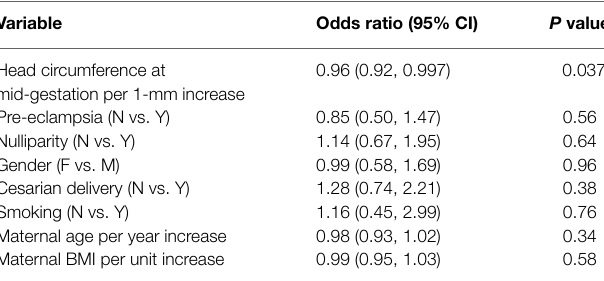
TABLE2 | Univariatelogisticregressionmodelsforanoutcomeofanallergy vs. no allergy . Variable Odds ratio (95% CI) P value